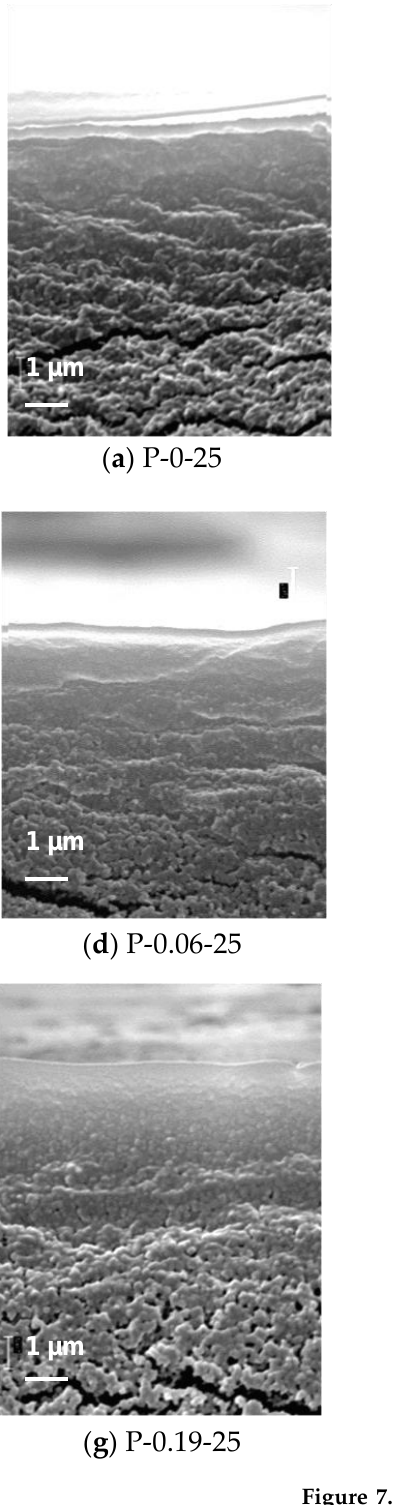
Figure 7. SEM micrographs of the enlarged fragment of the cross-section in the vicinity of the selective layer of PPSU and nanocomposite PPSU/O-MWCNTs ultrafiltration membranes prepared at coagulation bath temperatures 25 °C ( a – g ), 40 °C ( b – h ), and 70 °C ( c – i ), O-MWCNTs concentrations, wt.%: ( a ) – ( c ) — 0; ( d ) – ( f ) — 0.06; ( g ) – ( i ) — 0.19. It was shown that the introduction of O-MWCNTs to PPSU-PEG-20,000-PVP K-30 casting solution suppresses the formation of macrovoids and shifts them down against